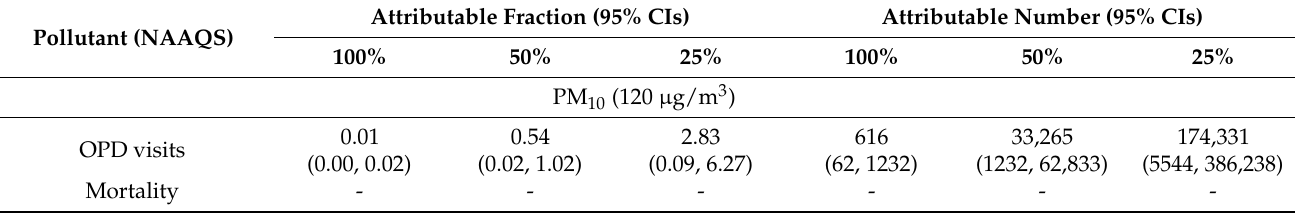
Table 6. Attributable fractions and attributable numbers of outpatient department (OPD) visits